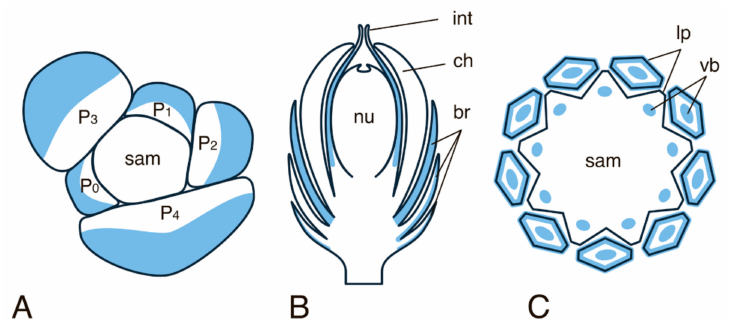
Figure 6. Expression pattern of YABBY homologs in gymnosperms. ( A ) Line drawing of the cross- section through the vegetative apex of Gingko biloba. ( B ) Longitudinal section through the ovule of E. distachya. ( C ) Line drawing of the cross-section through the vegetative apex of Pseudotsuga menziesii. Schemes are based on descriptions and photos of in situ RNA-RNA hybridizations from